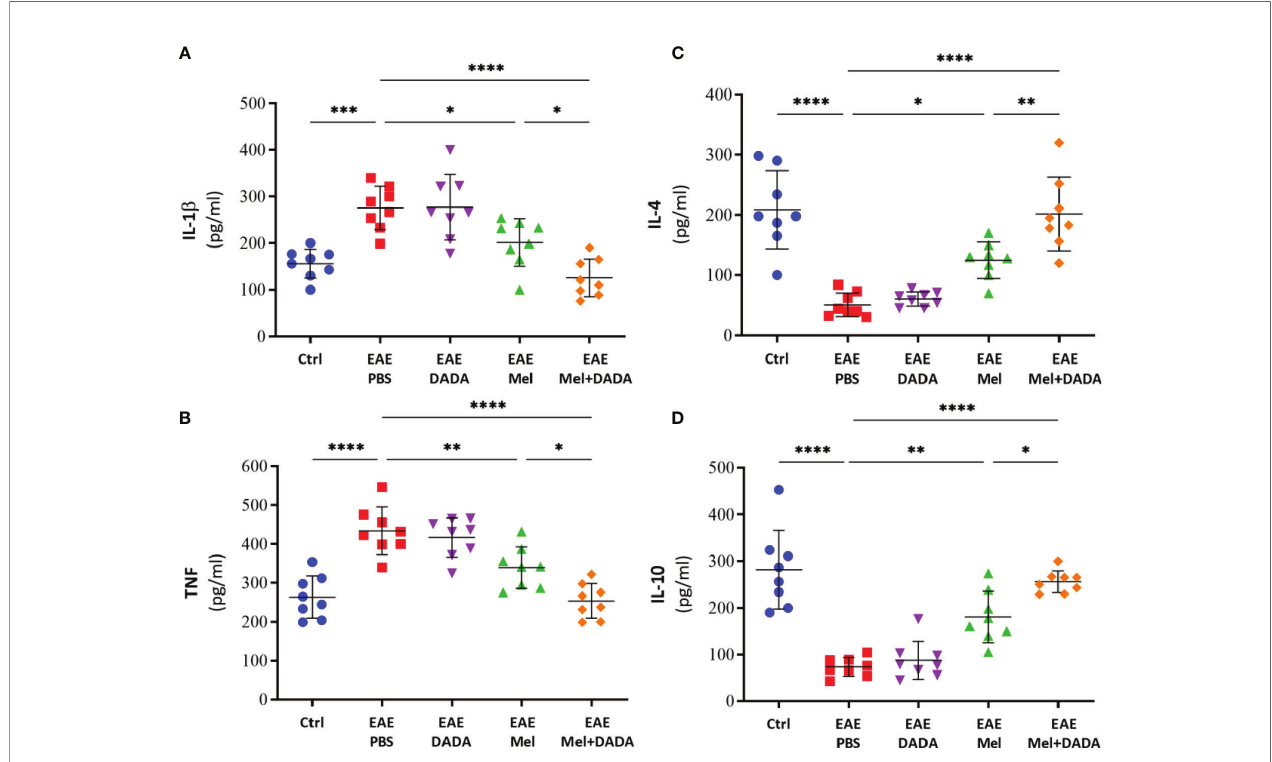
FIGURE 2 | The effects of melatonin, DADA, and combination therapy on cytokine levels in the brain. Brain homogenates were used to quantify the levels of pro-in fl ammatory cytokines (A) IL-1 b and (B) TNF and anti-in fl ammatory cytokines (C) IL-4 and (D) IL-10. Signi fi cance is indicated by *p < 0.05; **p < 0.01; ***p < 0.001 and ****p <